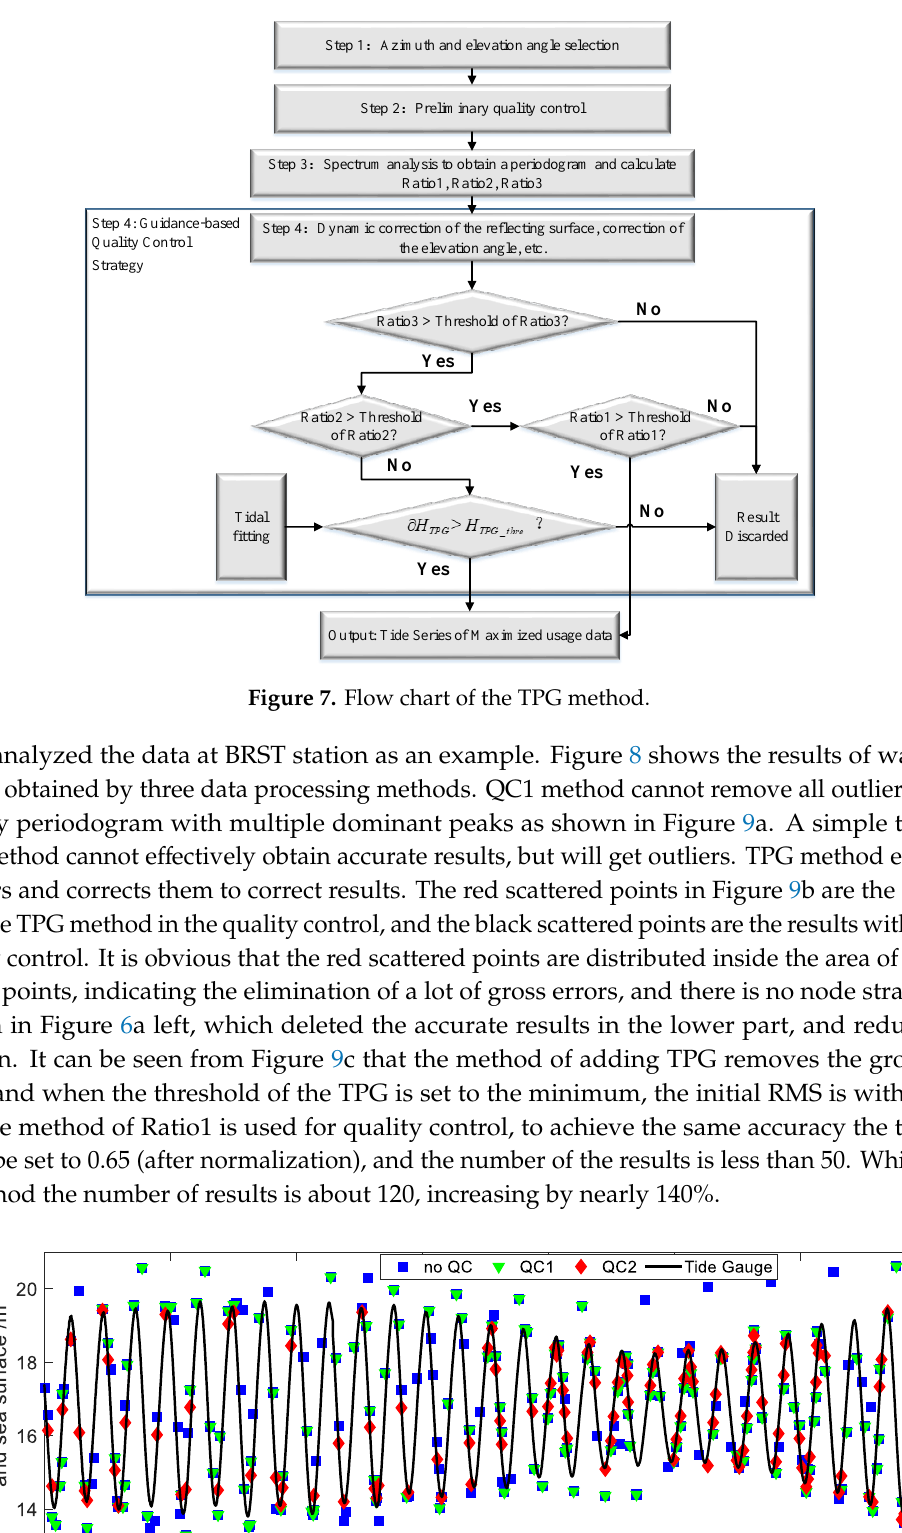
Figure 8. Comparison of different quality control methods for water level inversion at BRST Station. No QC means no quality control, QC1 refers to the threshold setting method of Ratio1, QC2 refers to the TPG method. The solid black line represents the records of tide gauge.